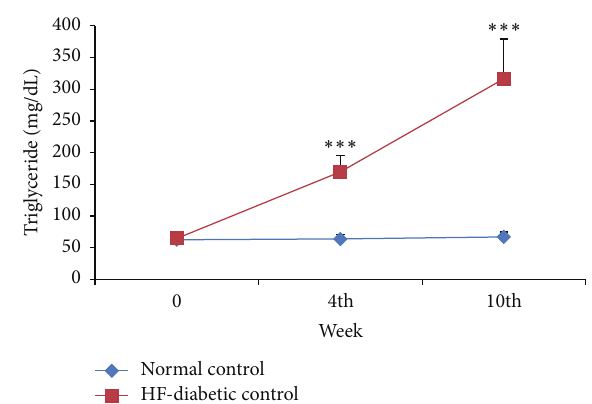
Figure 4: Time course changes in triglyceride of NC ( 𝑛 = 8 ), HF- DC group ( 𝑛 = 7 ). Values are expressed as mean ± SD. ∗∗∗ 𝑝 < 0.001 , NC versus